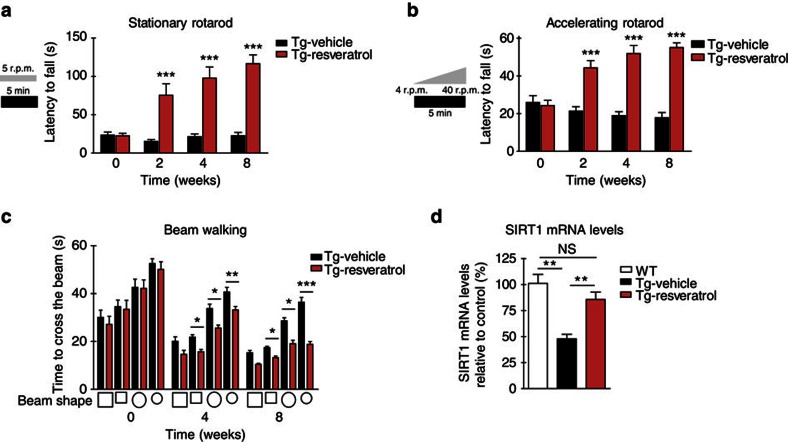
Peripheral administration of resveratrol ameliorates motor deficits and restores SIRT1 mRNA levels in Tg MJD mice.(a,b) Resveratrol-treated Tg MJD mice showed a significant better performance in constant velocity (5 r.p.m.) and accelerated (from 4 to 40 r.p.m.) rotarods, since the second week of treatment (eighth week after birth), compared with vehicle-treated Tg MJD mice. (c) Beam walking test with two square beams (18 or 9 mm width) and two round beams (9 or 6 mm diameter), demonstrating an amelioration of the motor performance promoted by resveratrol. (d) SIRT1 mRNA levels are decreased in Tg MJD animals (Tg-Vehicle) in comparison with WT mice (WT). SIRT1 mRNA levels are re-established with 8 weeks of daily treatment with 10 mg kg−1 body weight of resveratrol (Tg-Resveratrol). Data represent mean±s.e.m. (a–c) NS, nonsignificant; *P<0.05, **P<0.01 and ***P<0.001 compared with Tg vehicle-treated mice. Two-way analysis of variance (ANOVA) with Bonferroni's post-hoc test. Unpaired Student's t-test. n=8–9. (d) Data represent mean±s.e.m. NS. P>0.05 and **P<0.01. Relative to WT mice. One-way ANOVA with Bonferroni's post-hoc test. WT: n=6; Tg-Vehicle: n=5; Tg-Resveratrol: n=5.